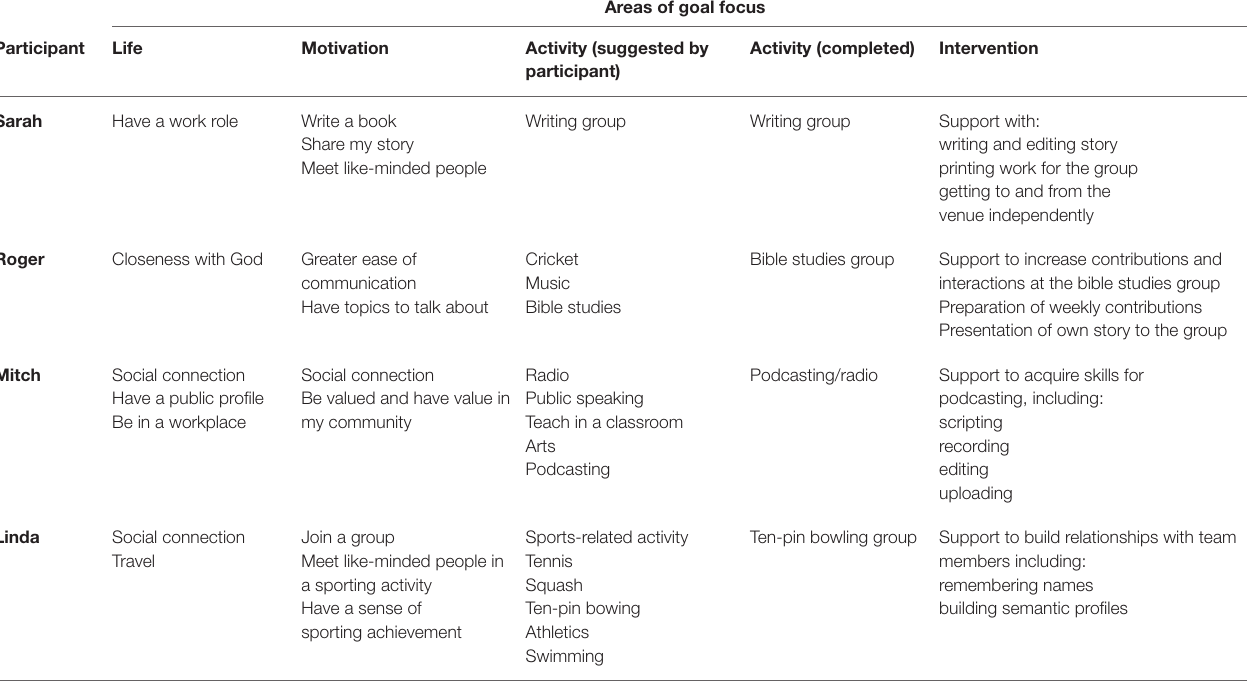
TABLE 3 | Four examples of participant goal